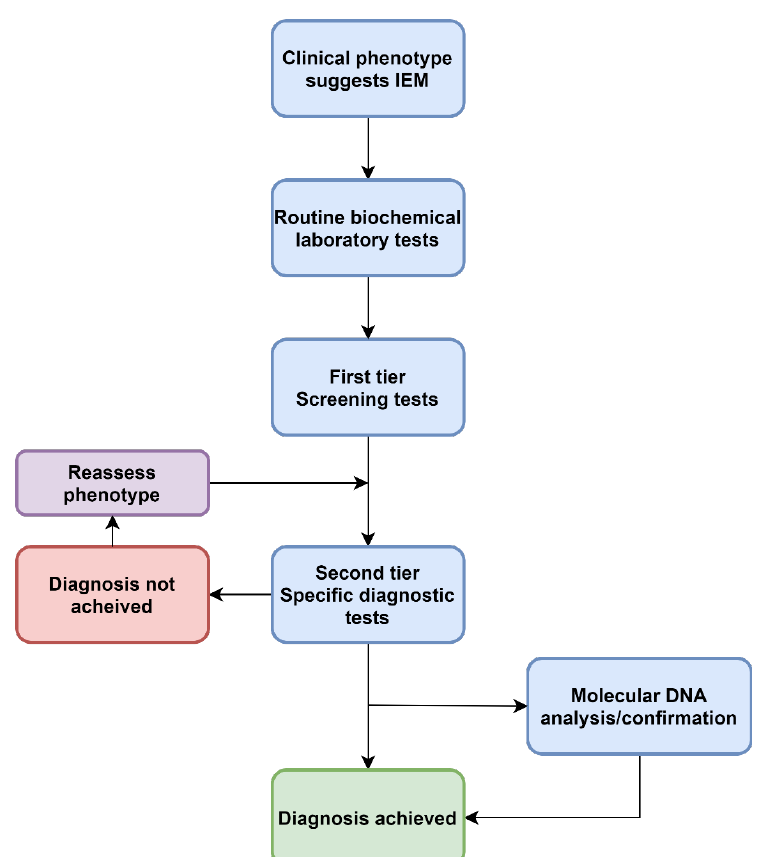
Figure 1. A traditional approach to diagnosing IEM. This describes a standard approach to screening that has not changed in